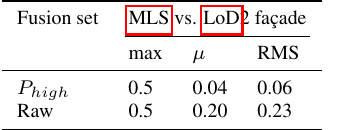
Table 1. Comparison of raw and P high fusion set deviations - all metrics given in meters.